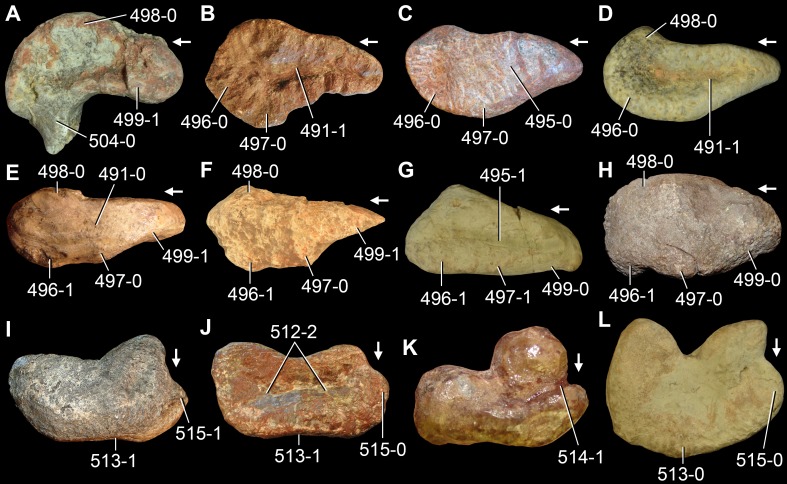
Femora of Triassic archosauromorphs in (A–H) proximal and (I–L) distal views.(A) Left element of Pamelaria dolichotrachela (ISI R316/1, mirrored); (B, J) left element of Erythrosuchus africanus (NHMUK R3592, mirrored); (C) right element of Dorosuchus neoetus (PIN 1579/61-2); (D) right element of Yarasuchus deccanensis (ISI Runnumbered); (E) right element of Chanaresuchus bonapartei (MCZ 4035); (F) left element of Parasuchus hislopi (ISI R42, mirrored); (G, L) left element of Silesaurus opolensis (ZPAL AbIII/361-25, mirrored); (H) right element of Herrerasaurus ischigualastensis (PVL 2566); (I) left element of Proterosuchus fergusi (SAM-PK-K140, mirrored); and (K) right element of Lagerpeton chanarensis (MCZ 4121). Numbers indicate character-states scored in the data matrix and the arrows indicate anterior/dorsal direction. Not to scale.